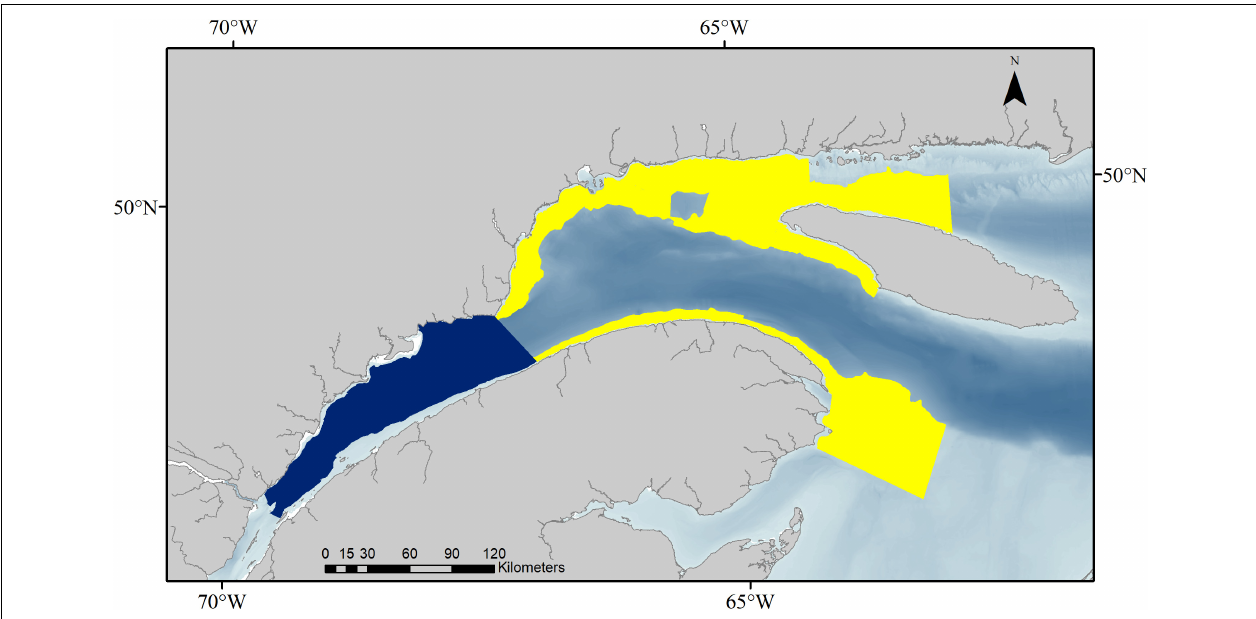
FIGURE 2 | Two regions, i.e., the Estuary of the St. Lawrence (dark blue) and the northwestern Gulf of the St. Lawrence (yellow) including the Gaspé peninsula, used to determine in situ vertical distributions of krill densities.